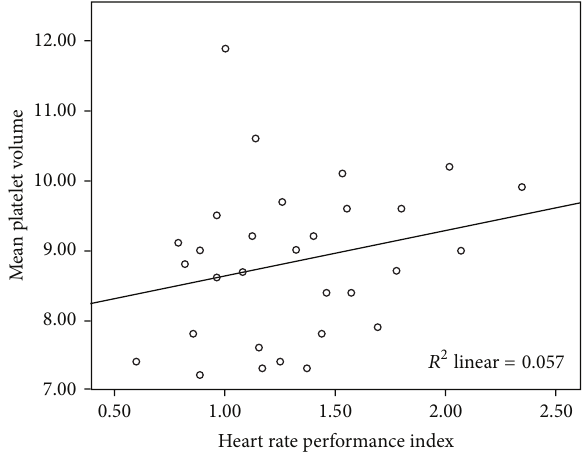
Figure 1: There was a positive correlation between heart rate performance index and mean platelet volume in OSA patients. ( 𝑟 = 0.343 , 𝑃 = 0.013 ).